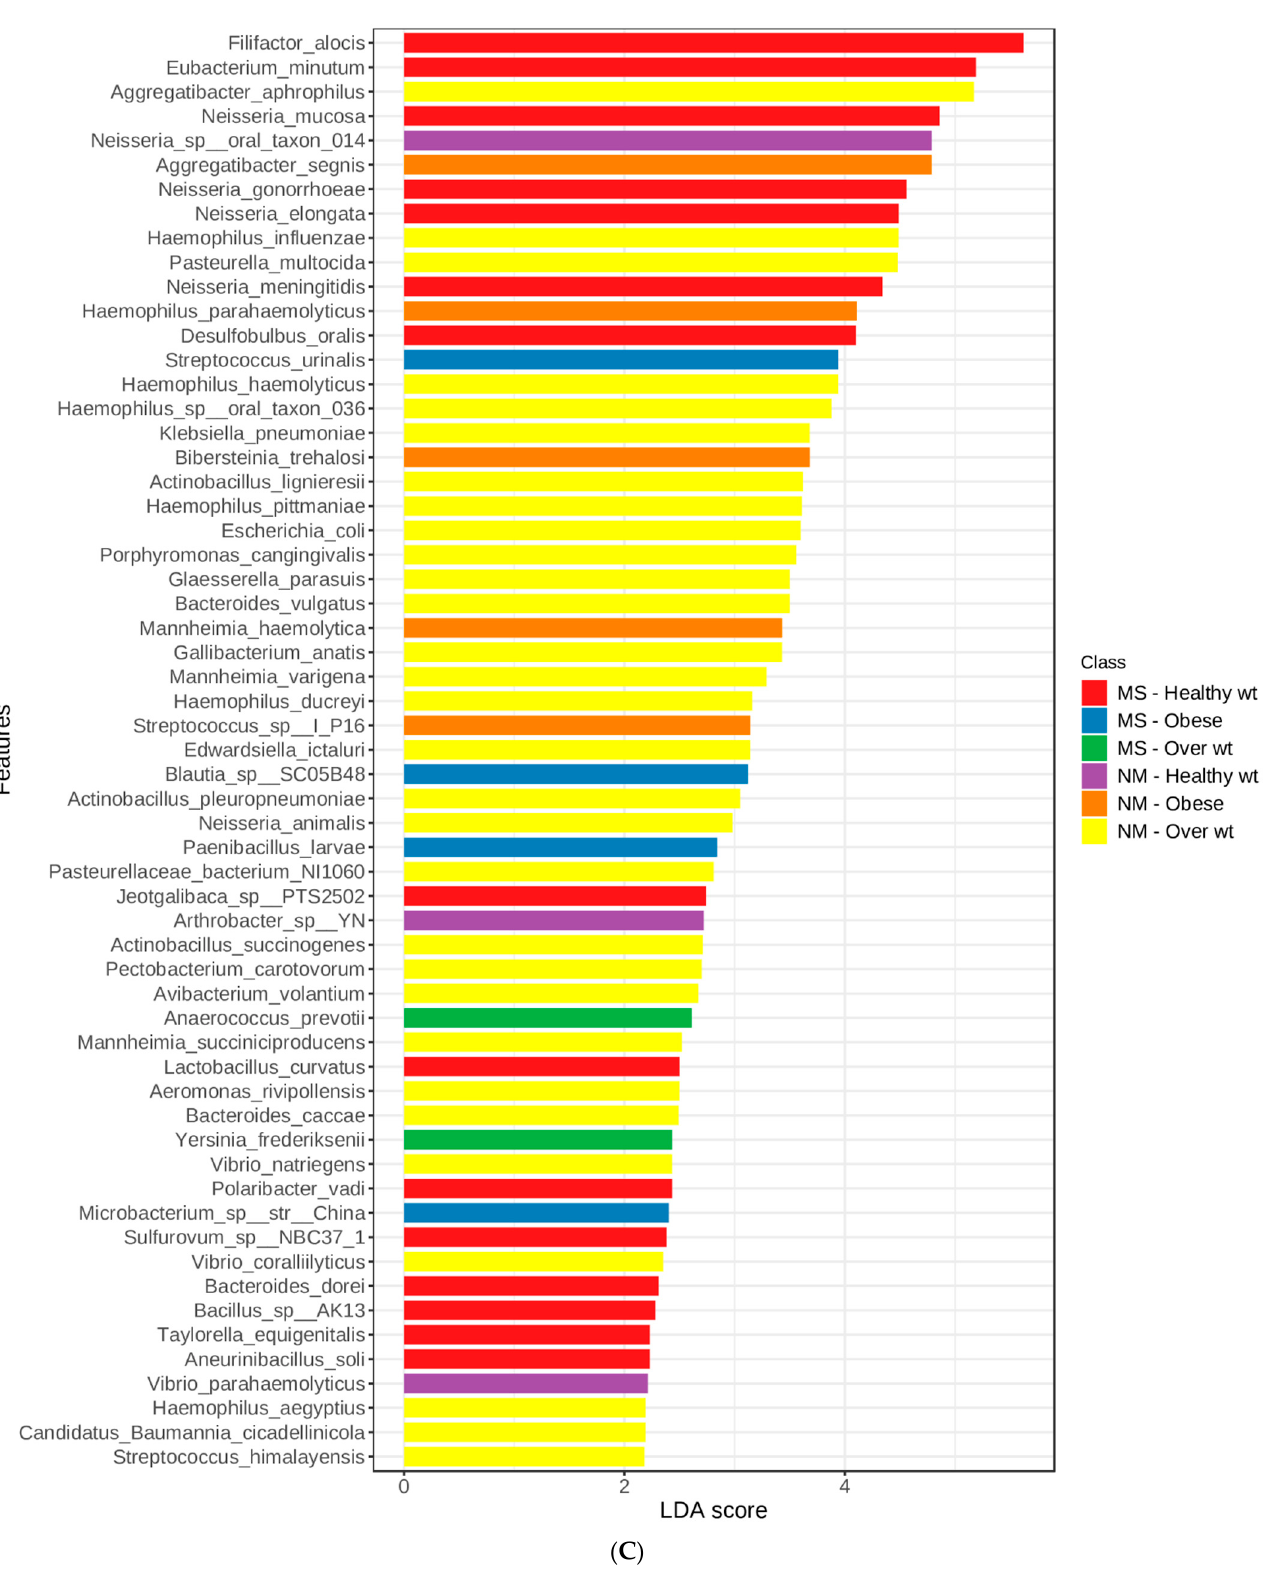
Figure 5. Species detected by linear discriminant analysis (LDA) effect size (LEfSe) in subjects grouped based on their BMI ( A ), periodontal health status ( B ), and both factors ( C ). The species shown are those that were significantly different among the groups ranked based on LDA score. Horizontal bars represent the effect size for each taxon.